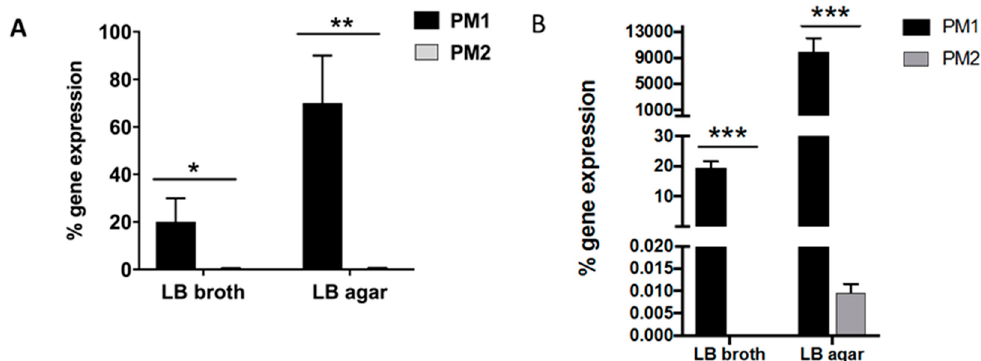
Figure 5. wosA ( A ); and flhDC ( B ) gene expression in PM1 and PM2 growth in LB broth or agar; data are expressed as a percentage of mRNA levels in each group normalized to 16S RNA. Data are mean ± SD. Significant differences are indicated by * p < 0.05, ** p < 0.01 and *** p < 0.001 for comparison of PM1 vs. PM2.